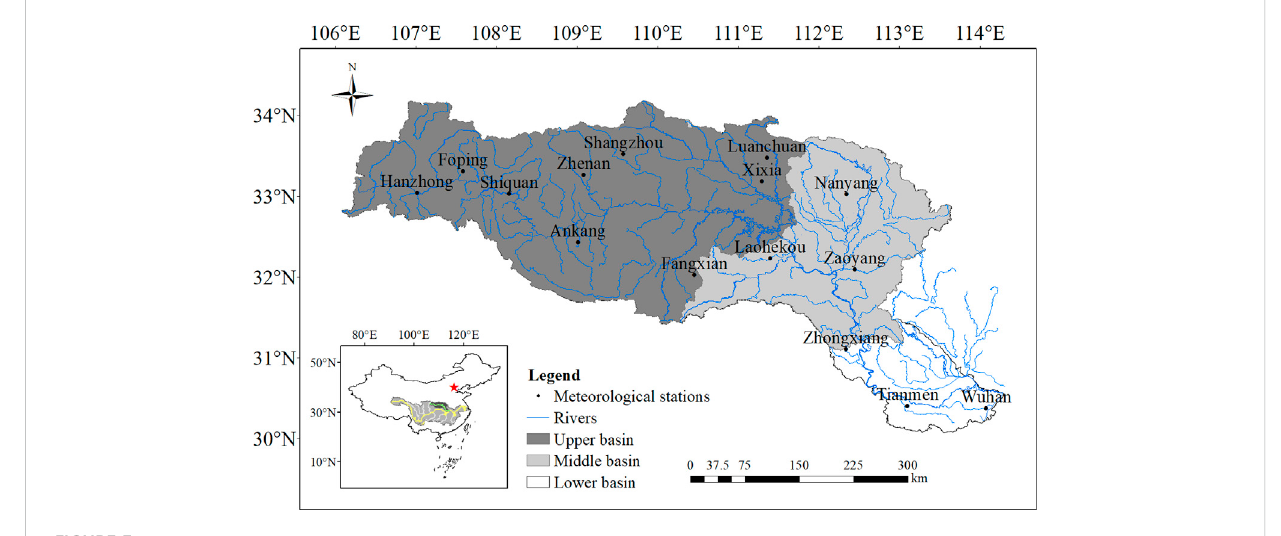
FIGURE 3 Locations of meteorological stations used in the